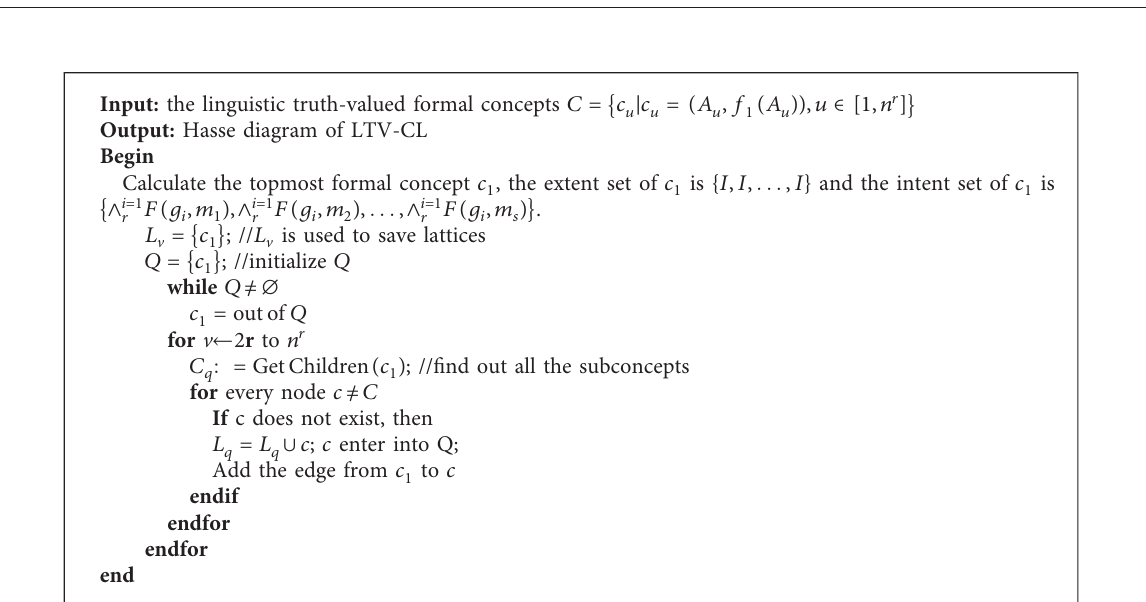
A LGORITHM 2: Hasse diagram of LTV-CL generation